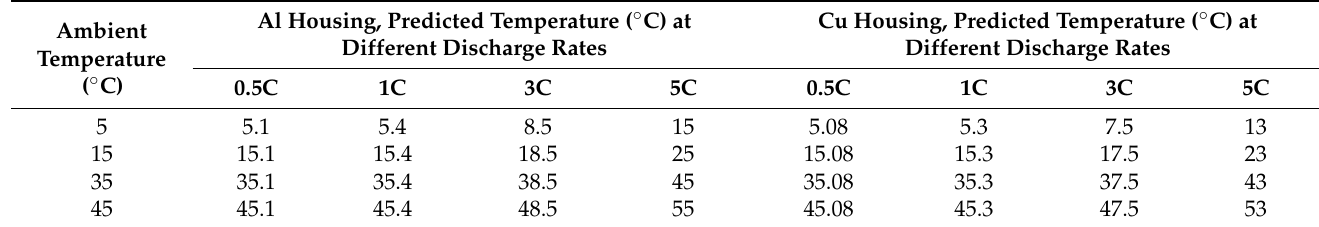
Figure 7. Maximum temperature elevations of battery pack implemented with ( a ) Al battery hous- ing and ( b ) Cu battery housing under different ambient temperatures at varied C rates. Table 3. Predicted Battery Temperature at varied C rates under different housing materials.